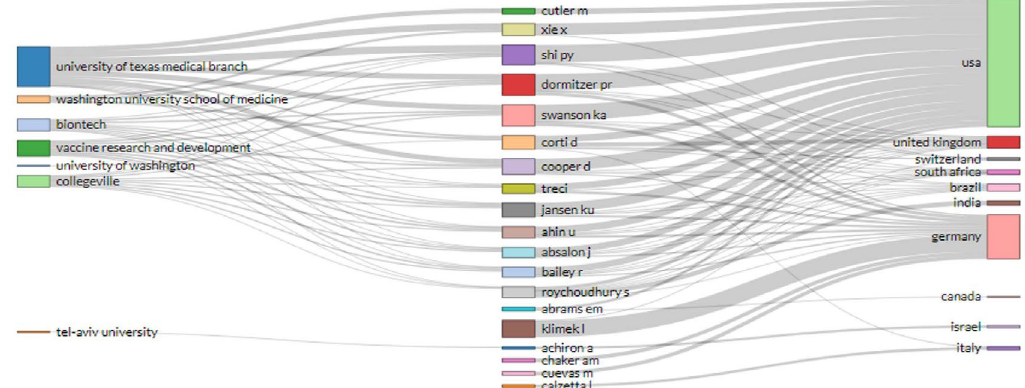
Fig. 5. The co-authorship network for authors, institutes and countries (three fields